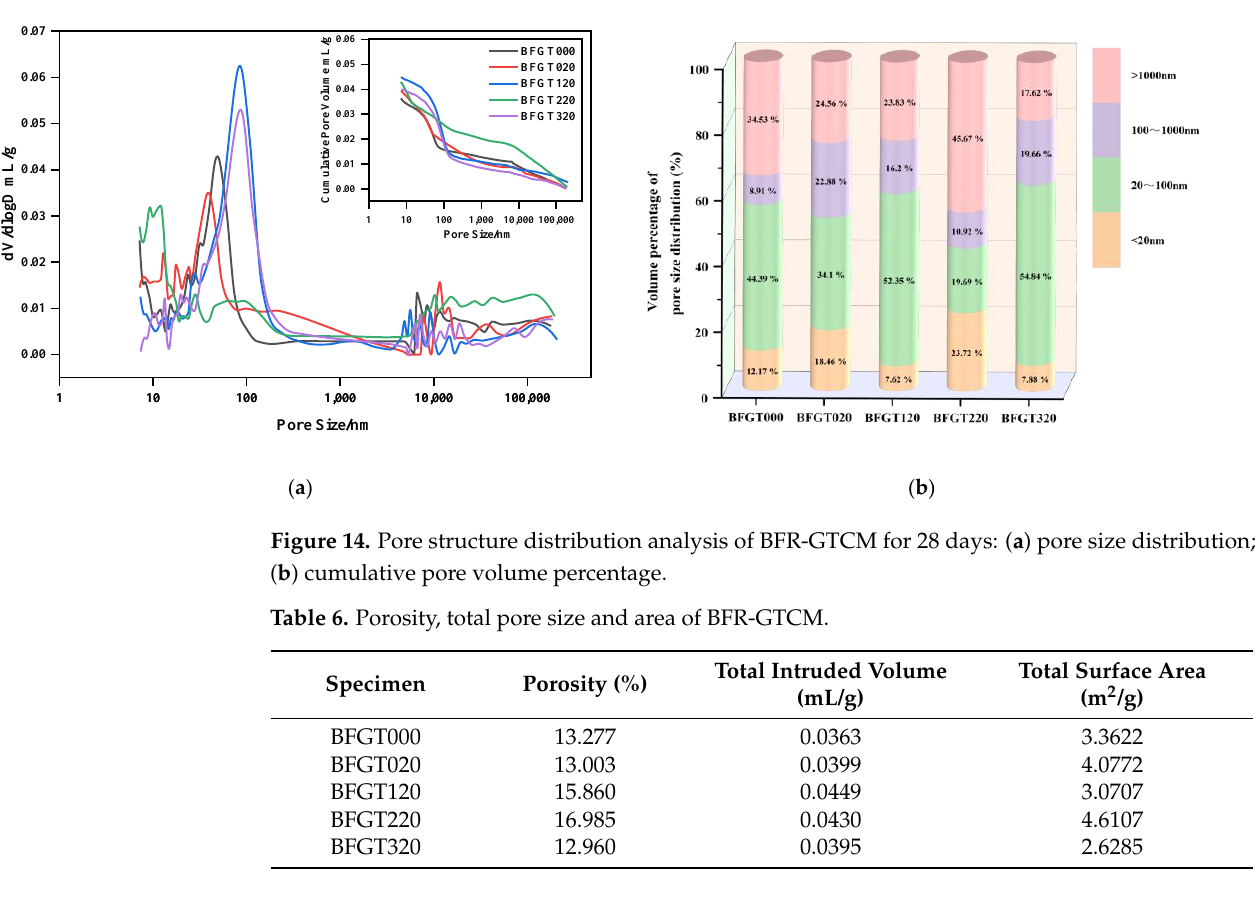
Figure 13. Functional group analysis of BFR-GTCM for 28 days.